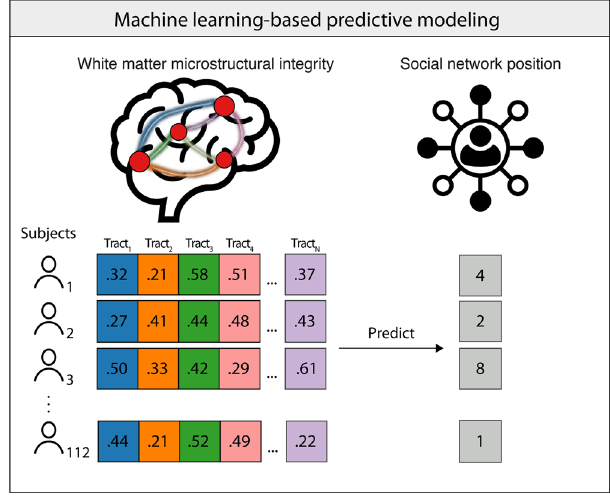
Fig. 3 Multivariate prediction of social network position characteristics based on patterns of white matter microstructural integrity. For each subject, average FA was extracted from each white matter tract in a given brain network, and the resulting set of FA values were used as predictors (as shown in different colors) in a ridge regression-based algorithm to predict individuals ’ social network position characteristics (see Methods for further details). This procedure was performed for the mirroring, affective processing, mentalizing, and face perception brain